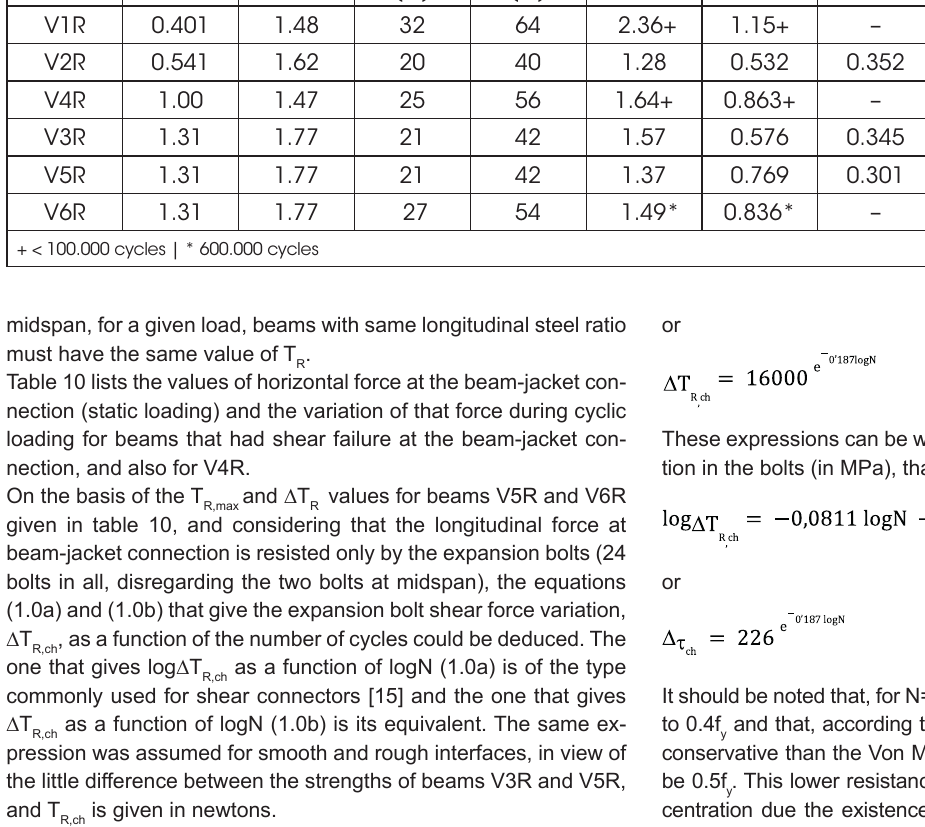
Maximum strain of the longitudinal tensile reinforcement of jacket and beam and strain variation during cyclic loading and residual strain at the end of loading